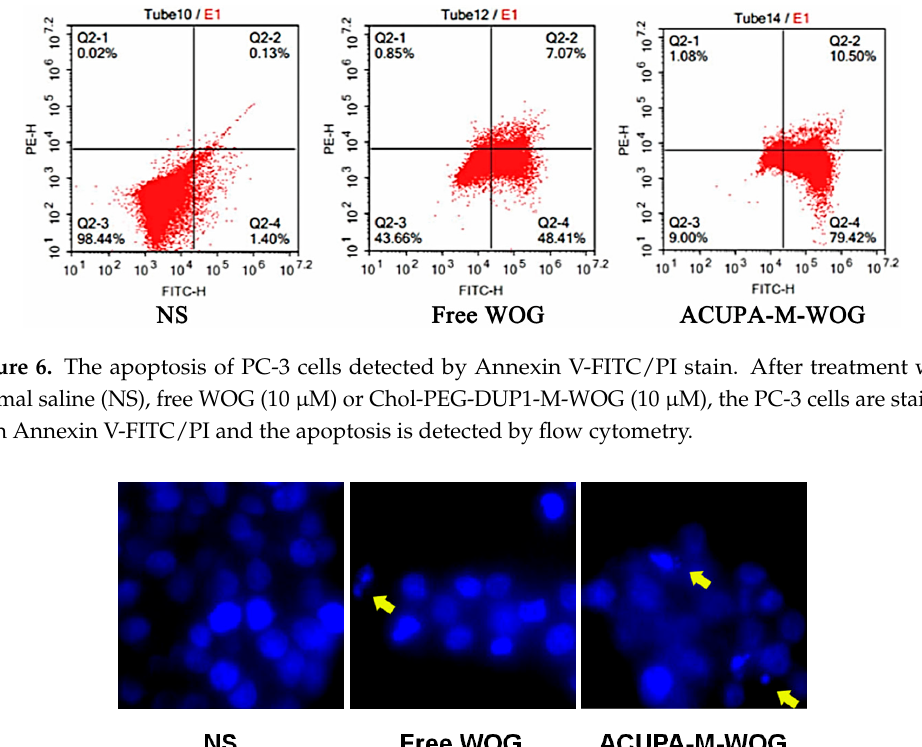
Figure 7. Fluorescent microscopic image. The yellow arrows mean the apoptotic cells. 40× objective lens.